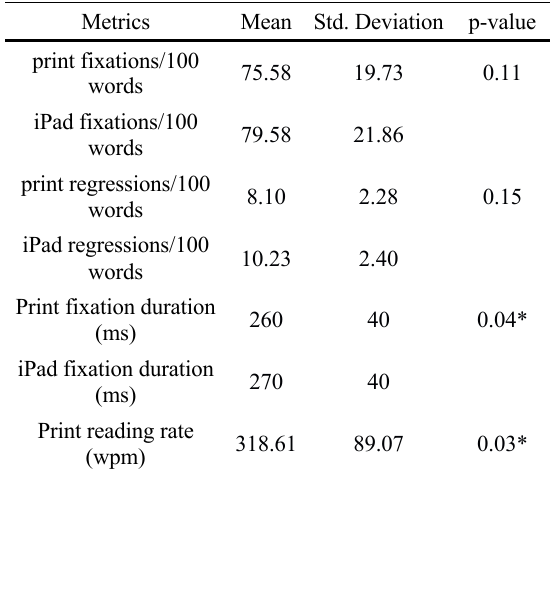
Table 2: Summary of mean and standard deviation of different eye movement metrics. Paired t-tests were performed, and its p- values are included. Significant p-values are marked with